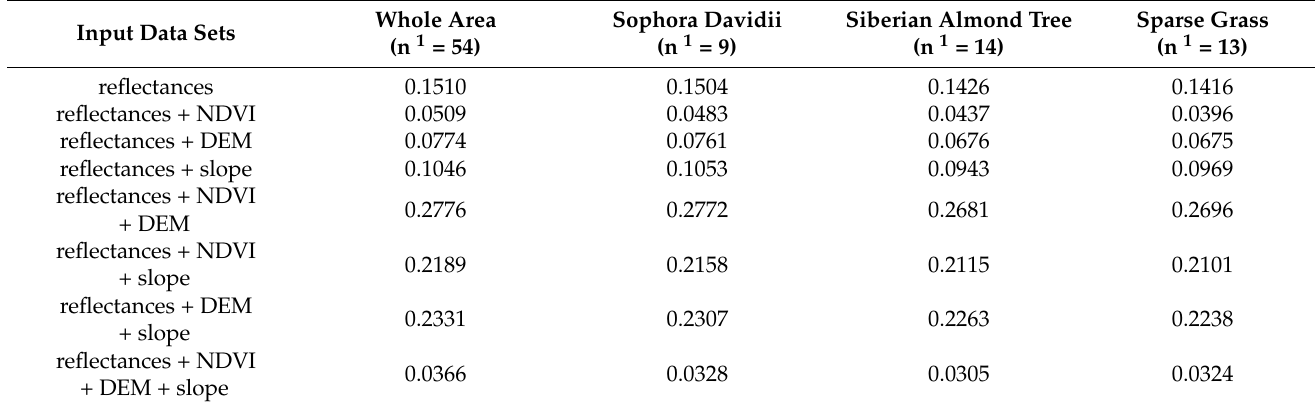
Table 3. RMSEs of the downscaled SM derived from 3 km SPL2SMAP_S SM product (m 3 /m 3 ).